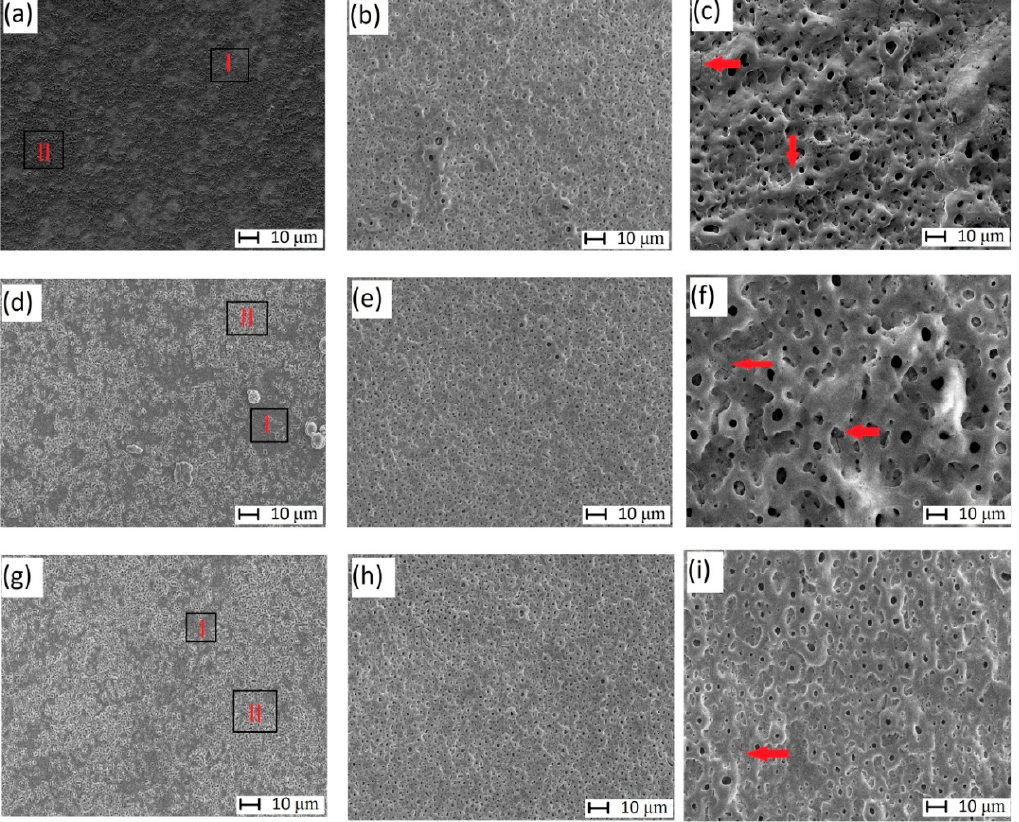
presented results are representative for three analyses of each surface treatment